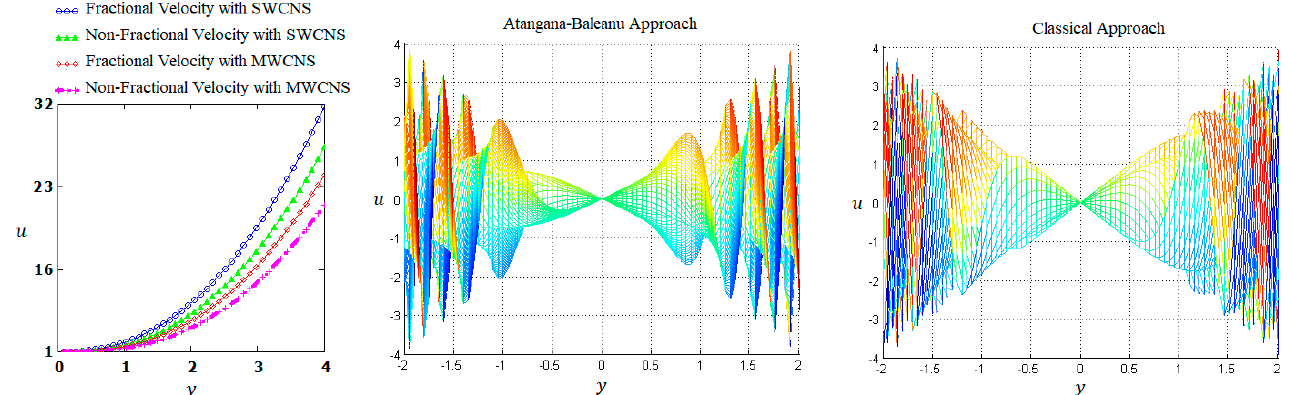
Figure 8. Velocity profile of single and multi-wall carbon nanotubes with and without ripple visualizations for 2-D and 3-D graphs based on fractional and non-fractional approaches.